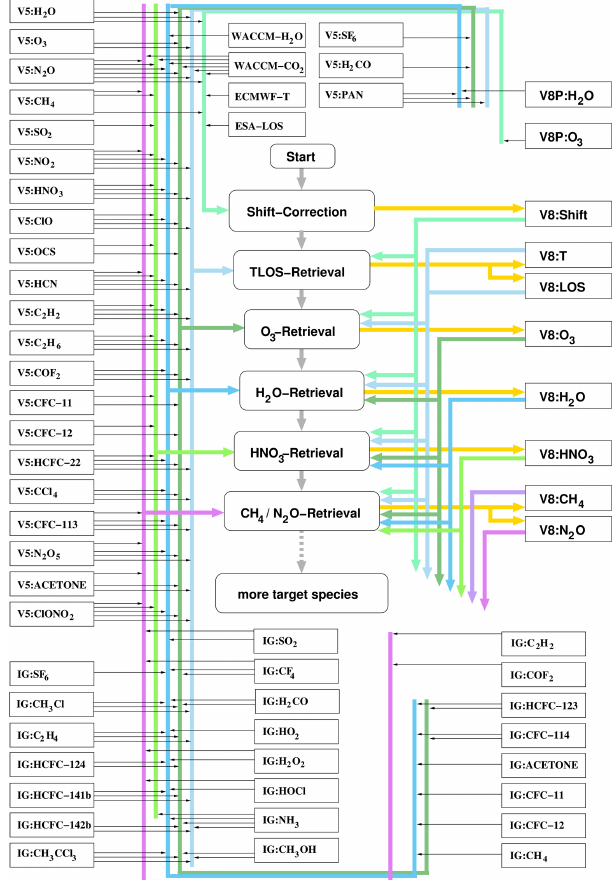
Figure 1. Data flow diagram of the sequential MIPAS process- ing chain. Mixing ratio information from the MIPAS initial guess database (IG; Kiefer et al., 2002, and updates thereof) is used when- ever no V5 or V8 MIPAS results of the related species are available. V8P stands for a preliminary V8 data